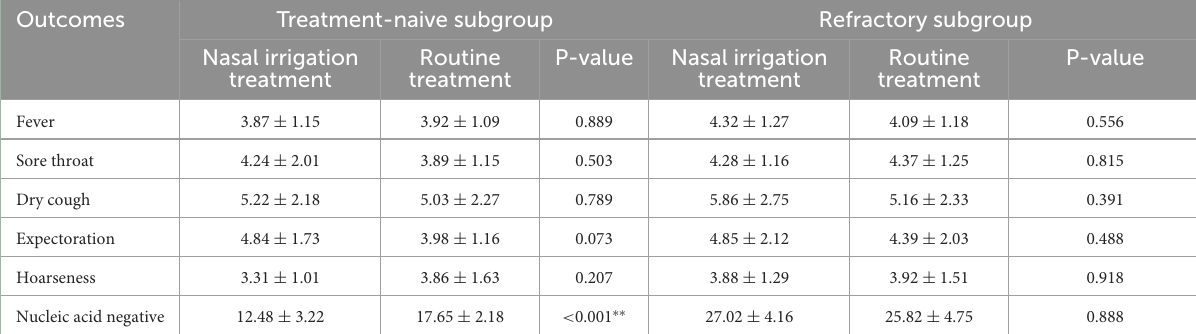
TABLE 5 Primary outcomes: symptom disappearance time and time of nucleic acid negative conversion (days). Outcomes